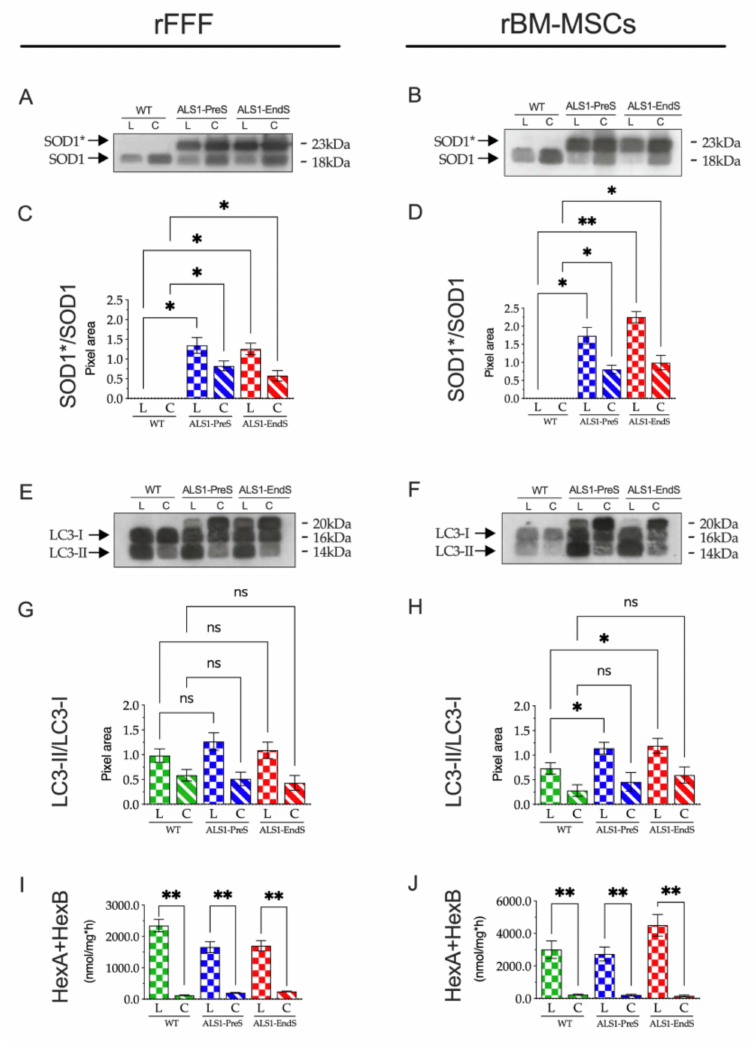
Figure 8. Expression of SOD1* and LC3 in lysosomal and cytoplasmatic fractions of rFFFs and rBM-MSCs from ALS1-PreS and ALS1-EndS animal models. ( A , B ) Representative Western blotting analysis is expressed as a ratio of the intensity of the SOD1*/SOD1 bands. ( C , D ) Densitometric analysis is expressed as a ratio of the intensity of the SOD1*/SOD1 bands. Results are reported as the mean ± SD of three replicates for each sample. * p < 0.05, ** p < 0.01. ( E , F ) Representative Western blotting analysis of LC3-I and LC3-II in ALS1 and WT cell fractions. ( G,H ) Densitometric analysis is expressed as a ratio of the intensity of the LC3-II/LC3-I bands. Results are reported as the mean ± SD of three replicates for each sample. * p < 0.05, ** p < 0.01. ( I , J ) Activity of Hexosaminidase (HexA + HexB) in ALS1 and WT cell fractions. Enzyme activity was measured by using the specific fluorogenic substrate MUG (see Section 2.14 for details). Results were expressed as the mean ± SD of three independent experiments, each in triplicates. L, lysosomal fraction; C, cytoplasmatic fraction. ns, not significant, * p < 0.05, ** p <